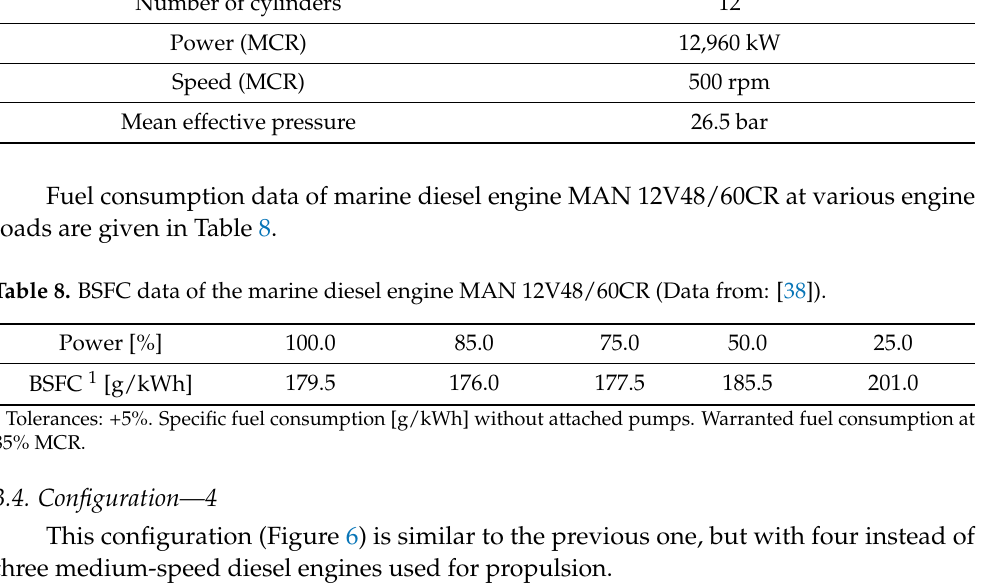
Characteristics